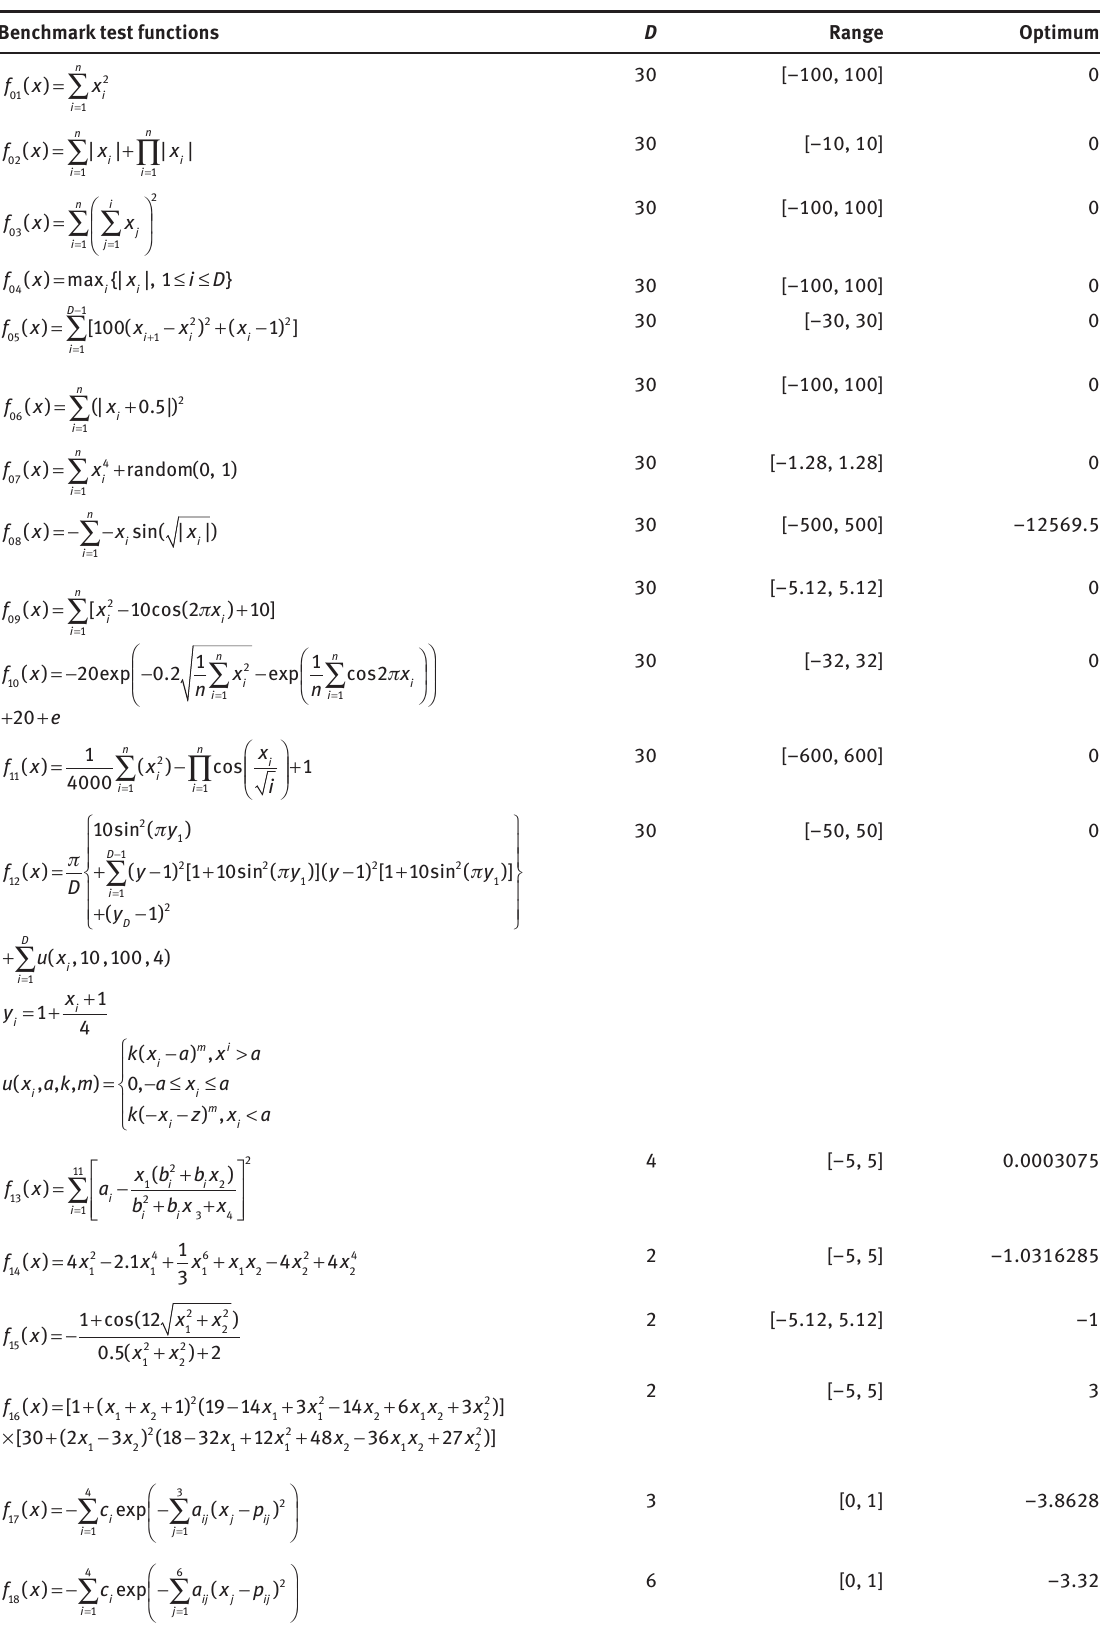
Table 1: Benchmark Test Functions. Benchmark test